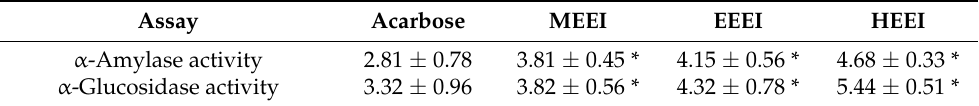
Table 5. IC 50 values (in µg/mL) of the antidiabetic activity of the extracts of Enteromorpha intesti- nalis .